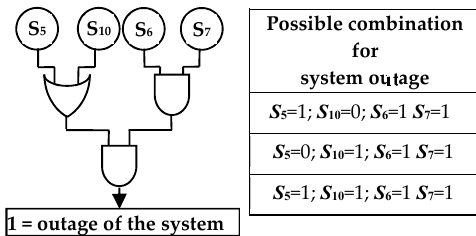
Figure 8. Logic representation of the sub-systems S 6 , S 11 , S 7 , S 8 of Figure 1.